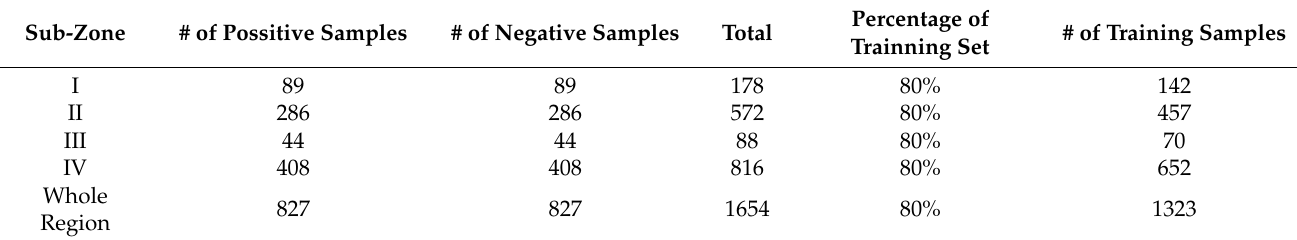
Table 3. The number of data points in different zonation and datasets.